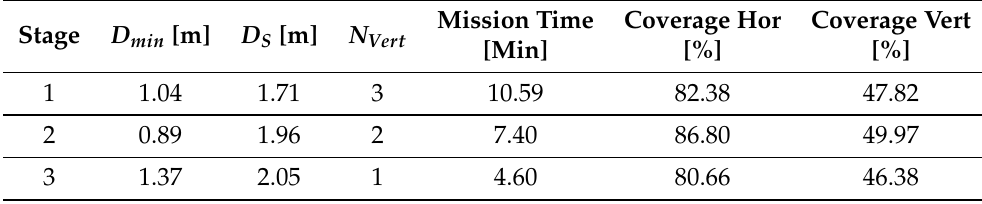
Table 6. Optimization in